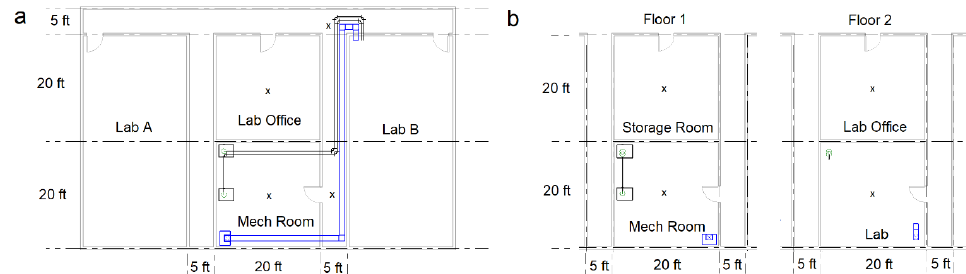
Figure 5. Scenario plans: ( a ) Scenario A plan; ( b ) Scenario B plans for floors 1 and 2.